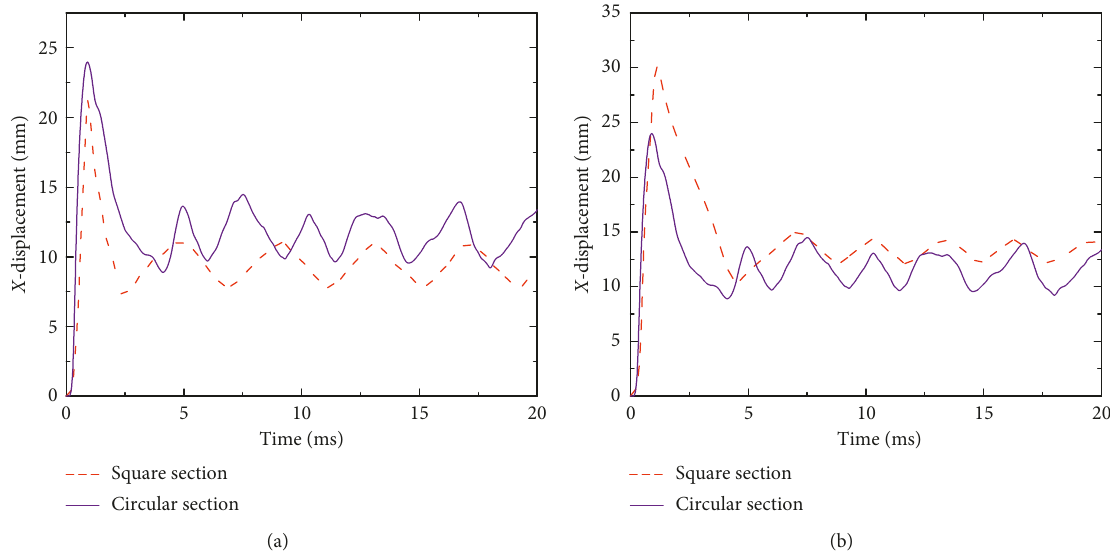
Figure 22: Comparison of midheight displacement with different cross sections. (a) Same section size. (b) Same material